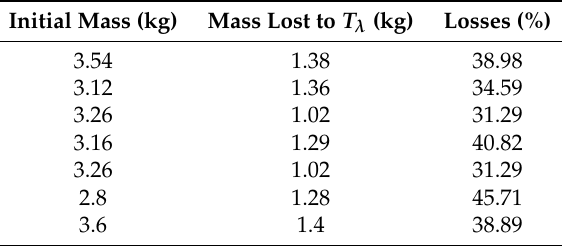
Table 4. Loss of helium when cooling to T λ for various experiments (own analysis, based on experimental data, which shows the difference between the initial mass and the final mass during the